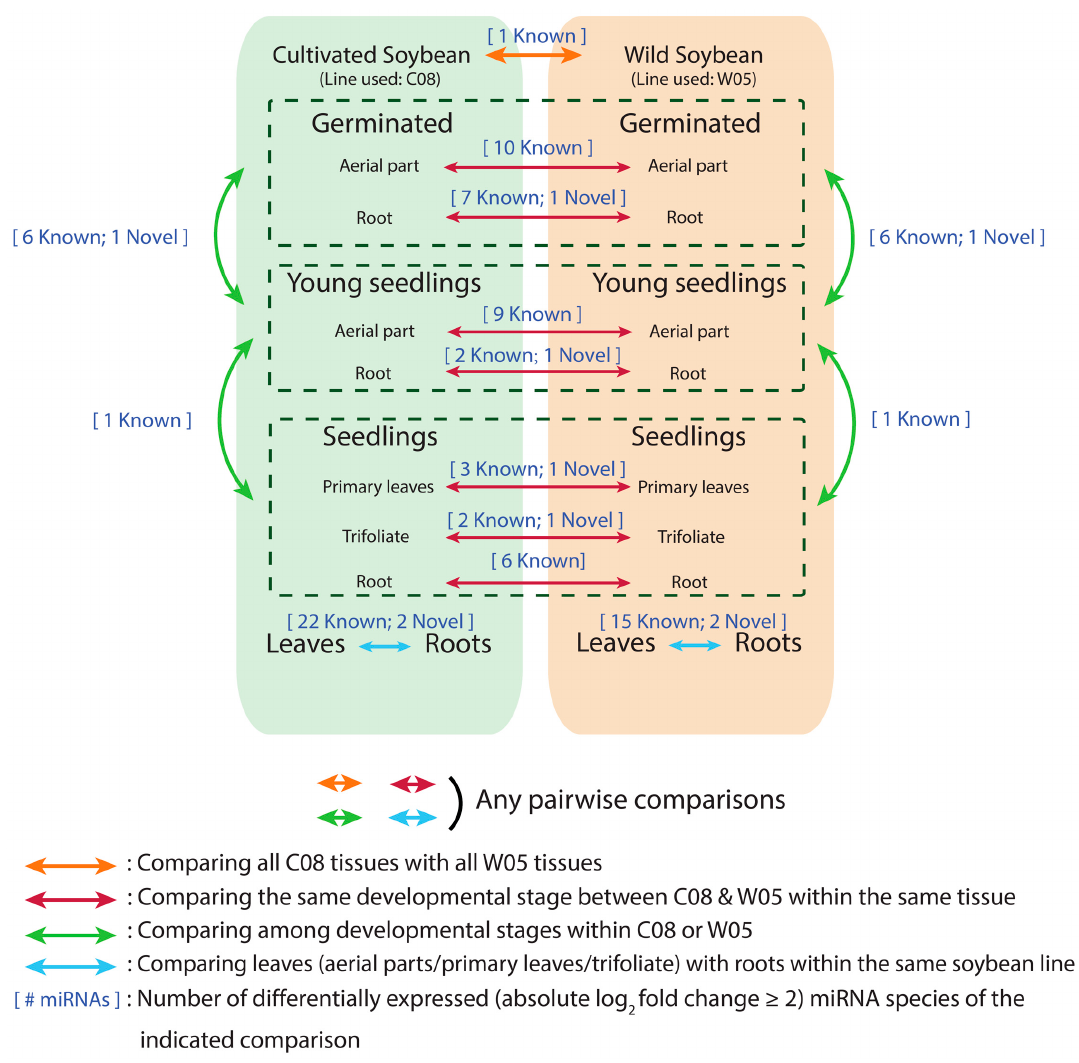
Figure 3. Differential miRNA expressions between different samples. We studied miRNAs with >3000 counts in seven samples of C08 or W05. Differential expression analysis was performed between C08 samples and W05 samples (orange and red arrows), between leaf samples and root samples (blue arrows), and between developmental stages (green arrows). Details of these miRNAs are presented in Table S4.